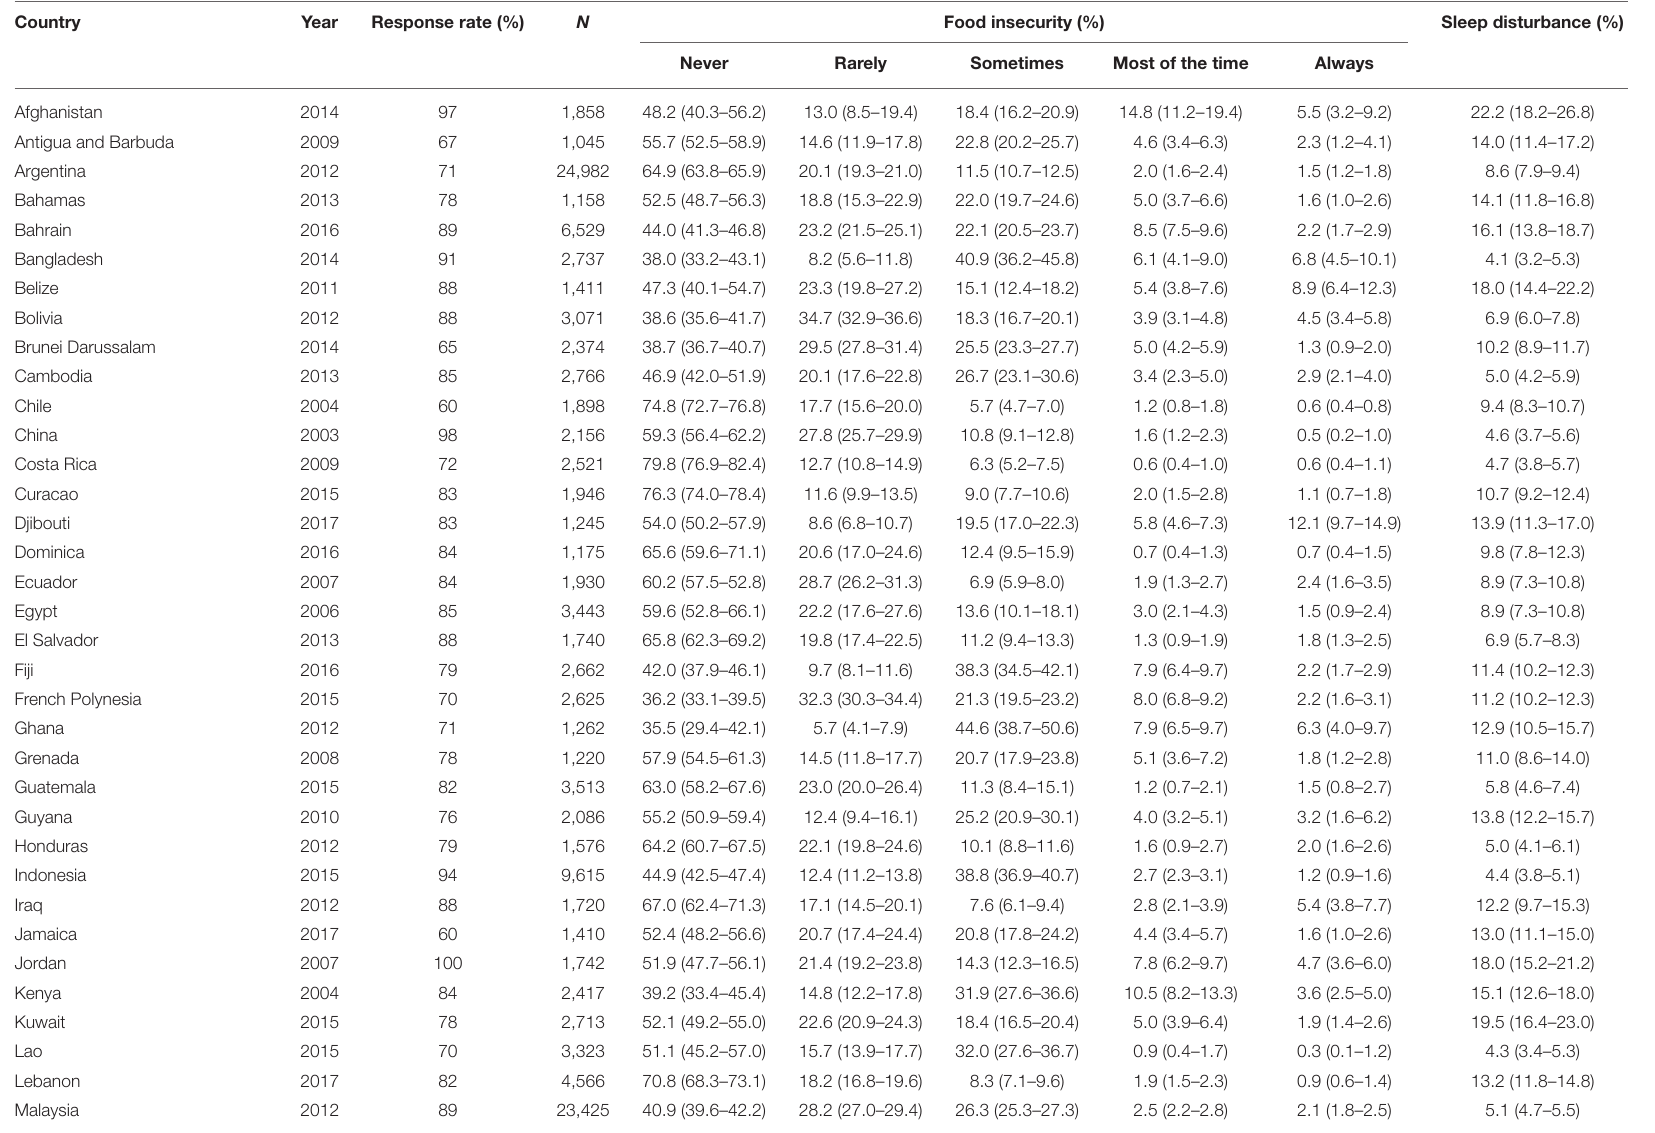
TABLE 1 | Prevalence of food insecurity and sleep disturbance by country. Country Year Response rate (%) N Food insecurity (%) Sleep disturbance (%) Never Rarely Sometimes Most of the